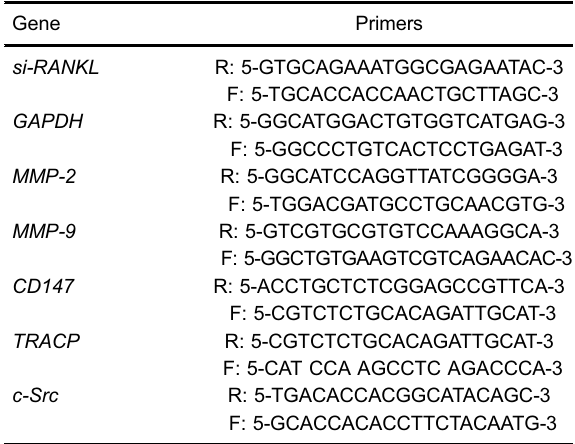
Table 1. Primer sequences used in the study.